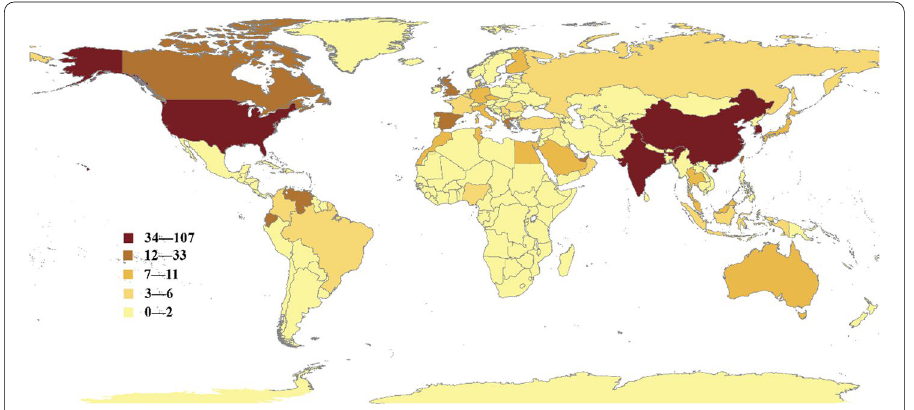
Fig. 4 Geographical distribution of the smart learning